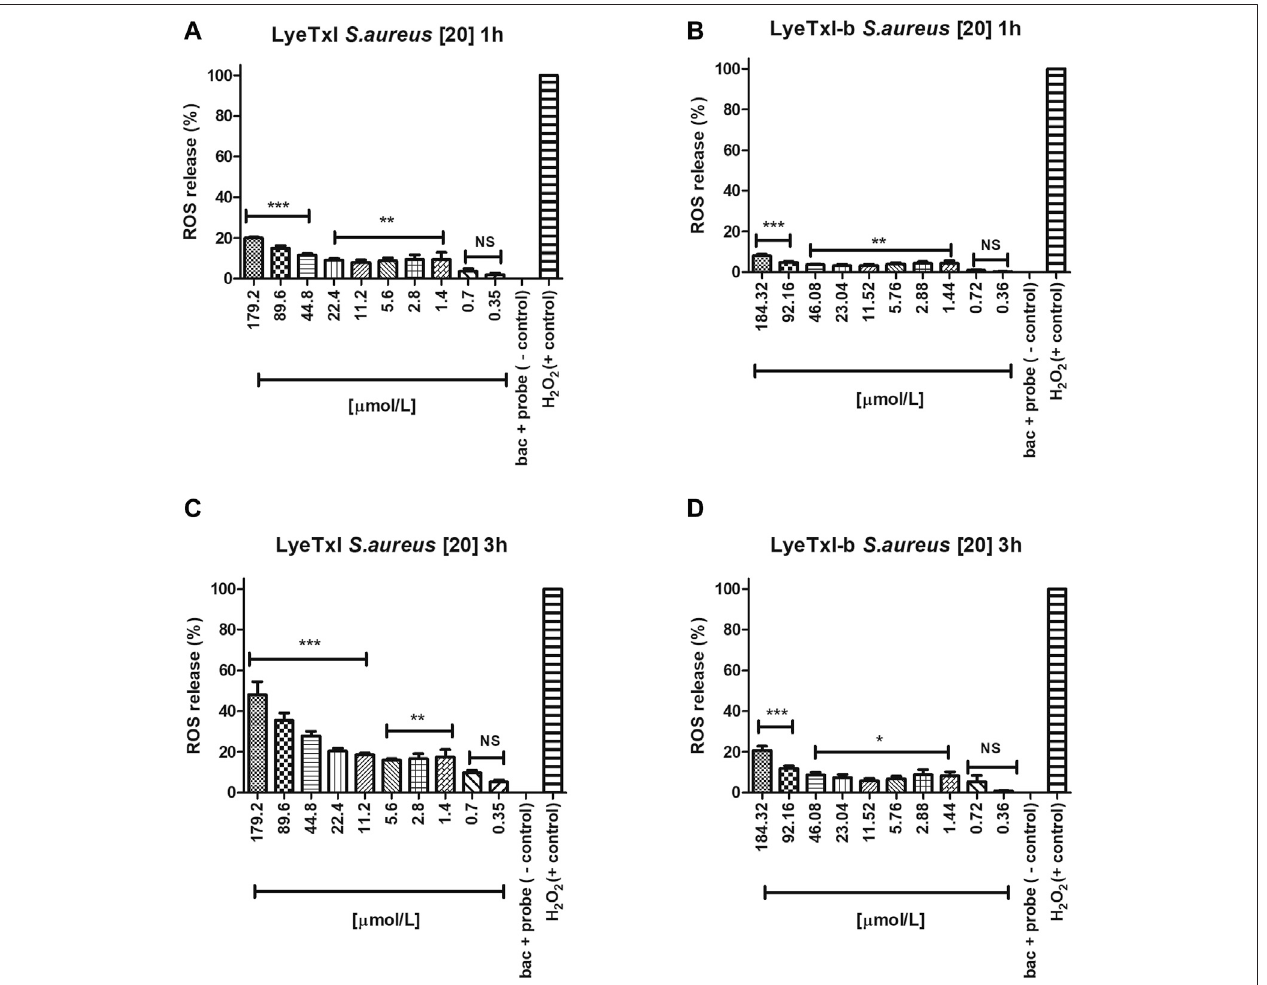
FIGURE5| Quanti fi cationofoxidativestress. S.aureus [20]wasincubatedwiththepeptides,at1and3 h,withdifferentconcentrationsofLyeTxI (A,C) andLyeTxI- b (B,D) . Data were statistically analyzed by simple variance ANOVA followed by post-test Turkey, with * p < 0.05; ** p < 0.01 and *** p < 0.001 in relation to the negative control, NS (cid:2) not signi fi